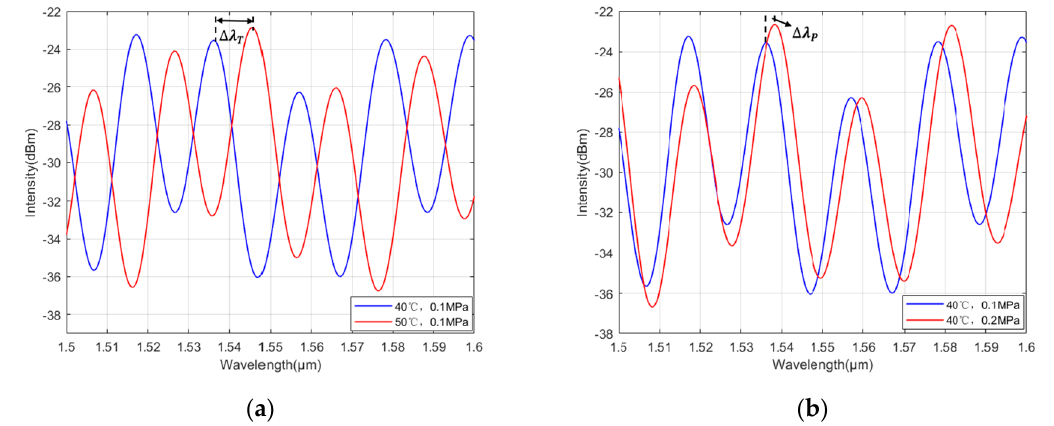
Figure 2. ( a ) The theoretical spectrum of temperature ( ∆ T = 10 ◦ C) response ( ∆ λ T ≈ 10.0 nm); and ( b ) the theoretical spectrum of pressure ( ∆ P ≈ 0.1 MPa) response ( ∆ λ T ≈ 0.9 nm).